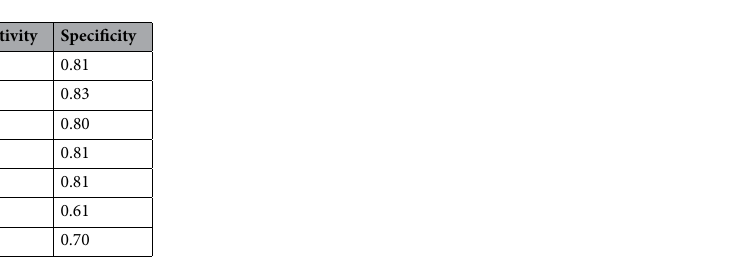
Table 2. Accuracy, sensitivity and specificity of the prediction models. LR logistic regression, RF random forest, ANN artificial neural network, SVM support vector machine, XGB extreme gradient